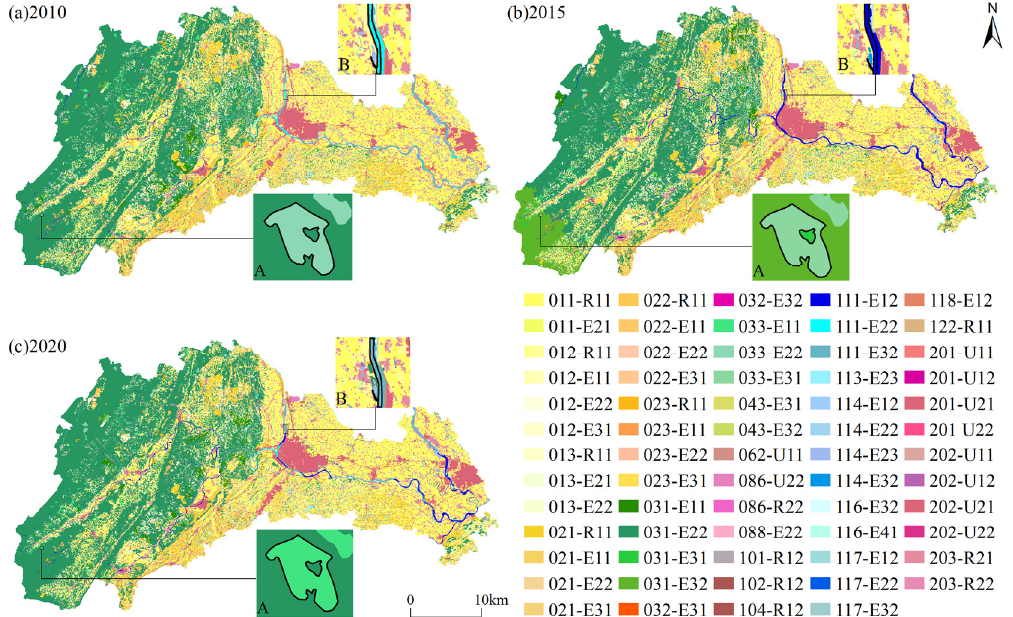
Figure 3. Spatial distribution of the land use superior TSFs in Qionglai. ( a – c ) are spatial distribution of the land use superior TSFs in 2010, 2015 and 2020. R11, E11 and so on have the meanings stated in Table 2; 011, 012 and so on are the land class code, have the meanings stated in the land use status classification in China (GB/T 21010-2007); e.g., 102-R11 indicates that the superior TSF of paddy field is agricultural products supply.